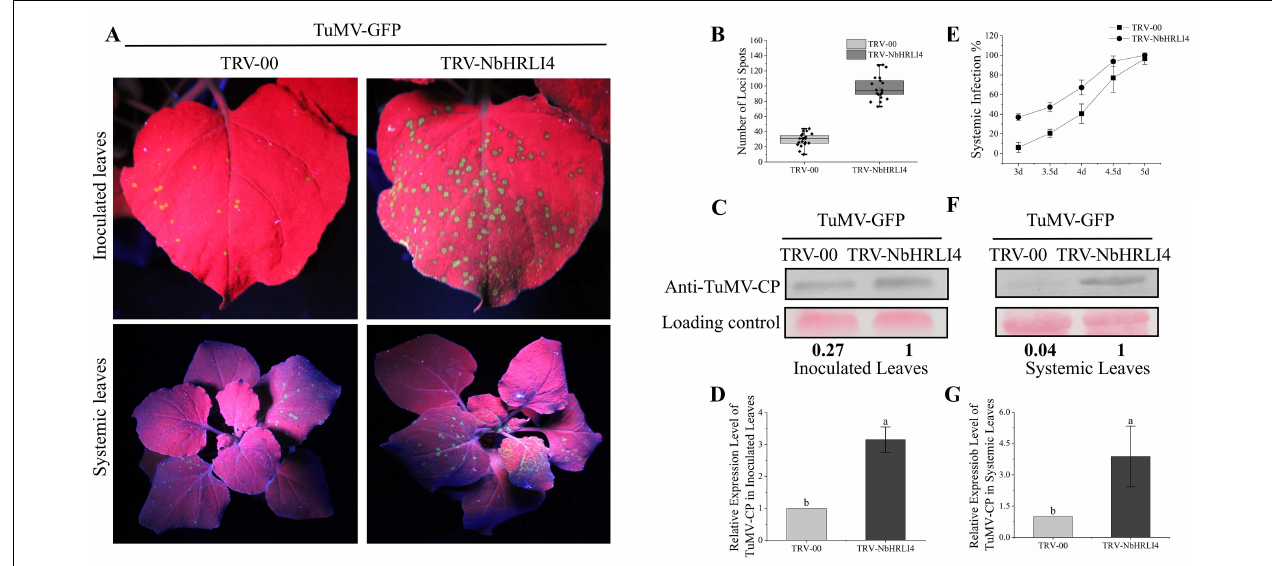
FIGURE 3 | Silencing of NbHRLI4 induced TuMV accumulation. (A) Inoculated and systemic leaves of plants inoculated with TuMV-GFP are observed under UV light. (B) Number of infection spots after TuMV infection of leaves inoculated with TRV-00 or TRV-HRLI4 (at least 20 plants per replicate) at 4 dpi. (C,D) Western blotting and RT-qPCR showing the increased expression of TuMV-CP (C) and mRNA (D) in inoculated leaves from TRV-NbHRLI4-infected plants compared with the TRV-00 infected plants at 3 dpi. (E) Percentage of plants systemically infected at different times after TuMV inoculation (at least 10 plants per replicate). (F,G) Western blotting and RT-qPCR showing the increased expression of TuMV-CP (F) and mRNA (G) in systemic leaves from TRV-NbHRLI4-infected plants compared with the TRV-00-infected plants at 5 dpi. The mean expression values in this figure were analyzed using t -test. Different letters on histograms indicate significant differences ( P <